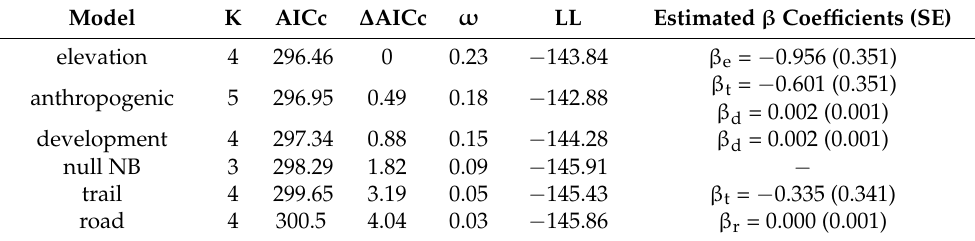
trail 299.65 3.19